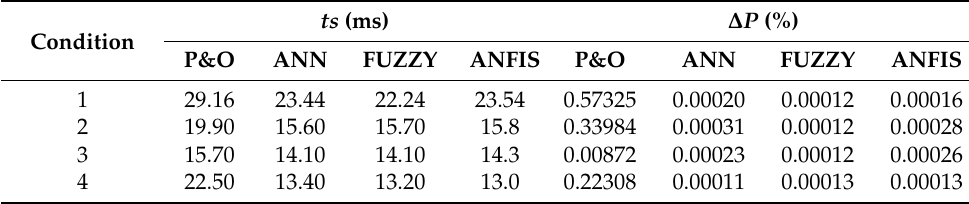
Table 9. The settling time and the oscillation around the MPP parameters.